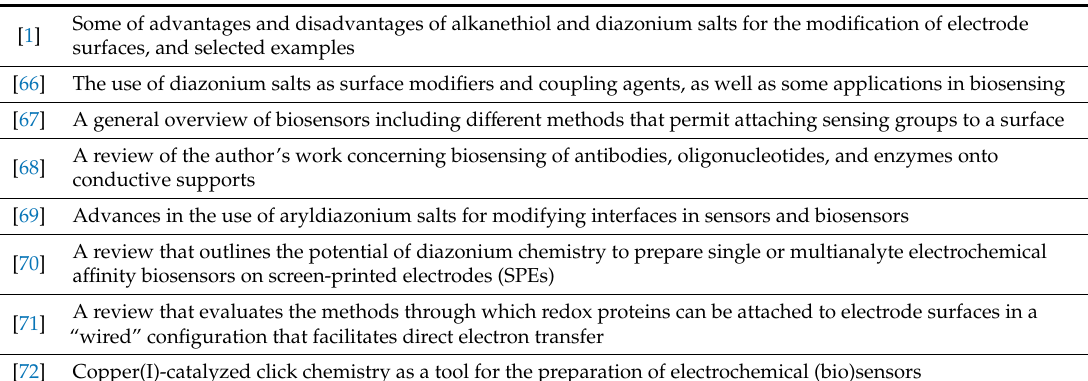
Table 1. Reviews on biosensors built with the help of diazonium